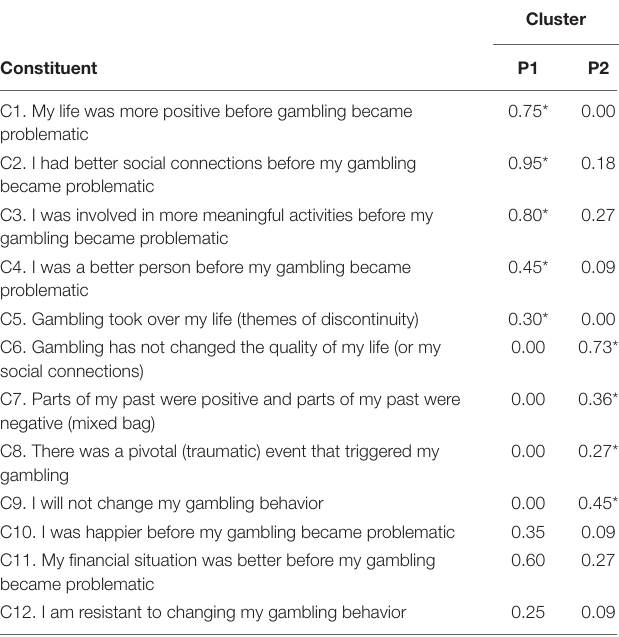
TABLE 2 | Proportion of cluster members expressing each constituent in each of the two clusters in the past